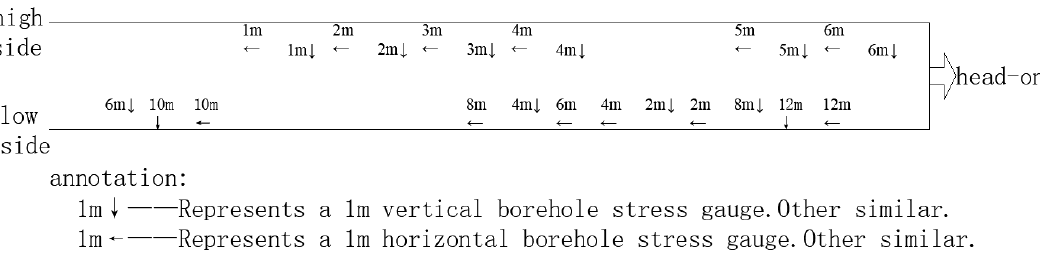
Figure 4. 11613 Graphic layout of measuring station.